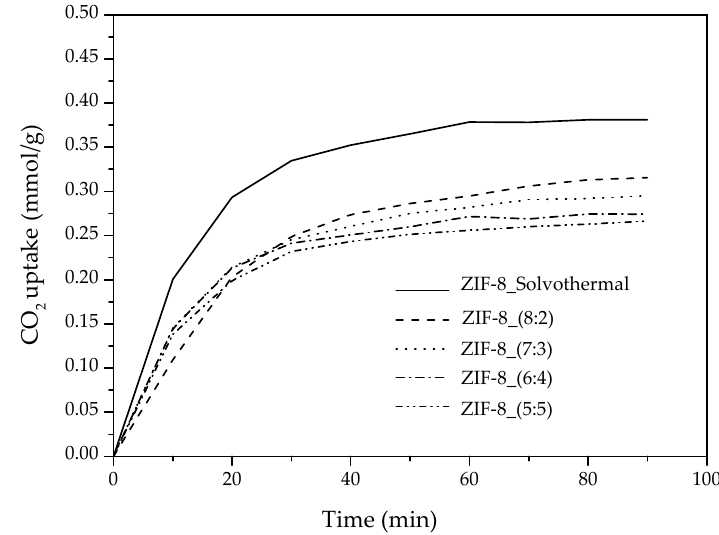
Figure 14. CO 2 uptake of ZIF-8 samples at different ratios between 2-MeIM and TMPAB compared with ZIF-8 synthesized by solvothermal method at 313 K.